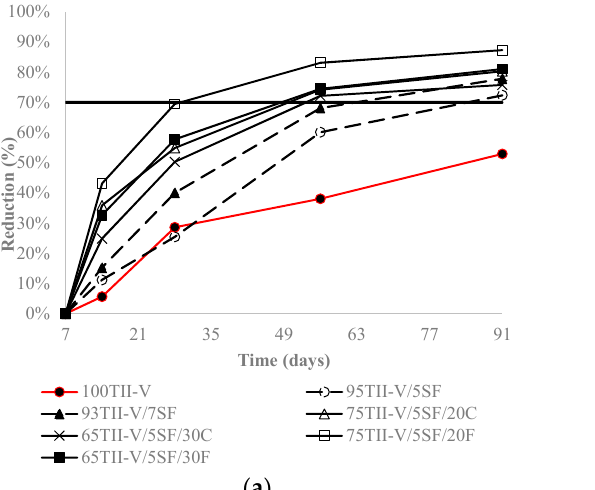
Figure 6. Influence of ( a ) silica fume, ( b ) metakaolin, and ( c ) slag on the reduction of charge passed in Class F-based ternary mixtures. The horizontal solid line represents the average reduction of charge passed for ternary mixtures at 91 days.